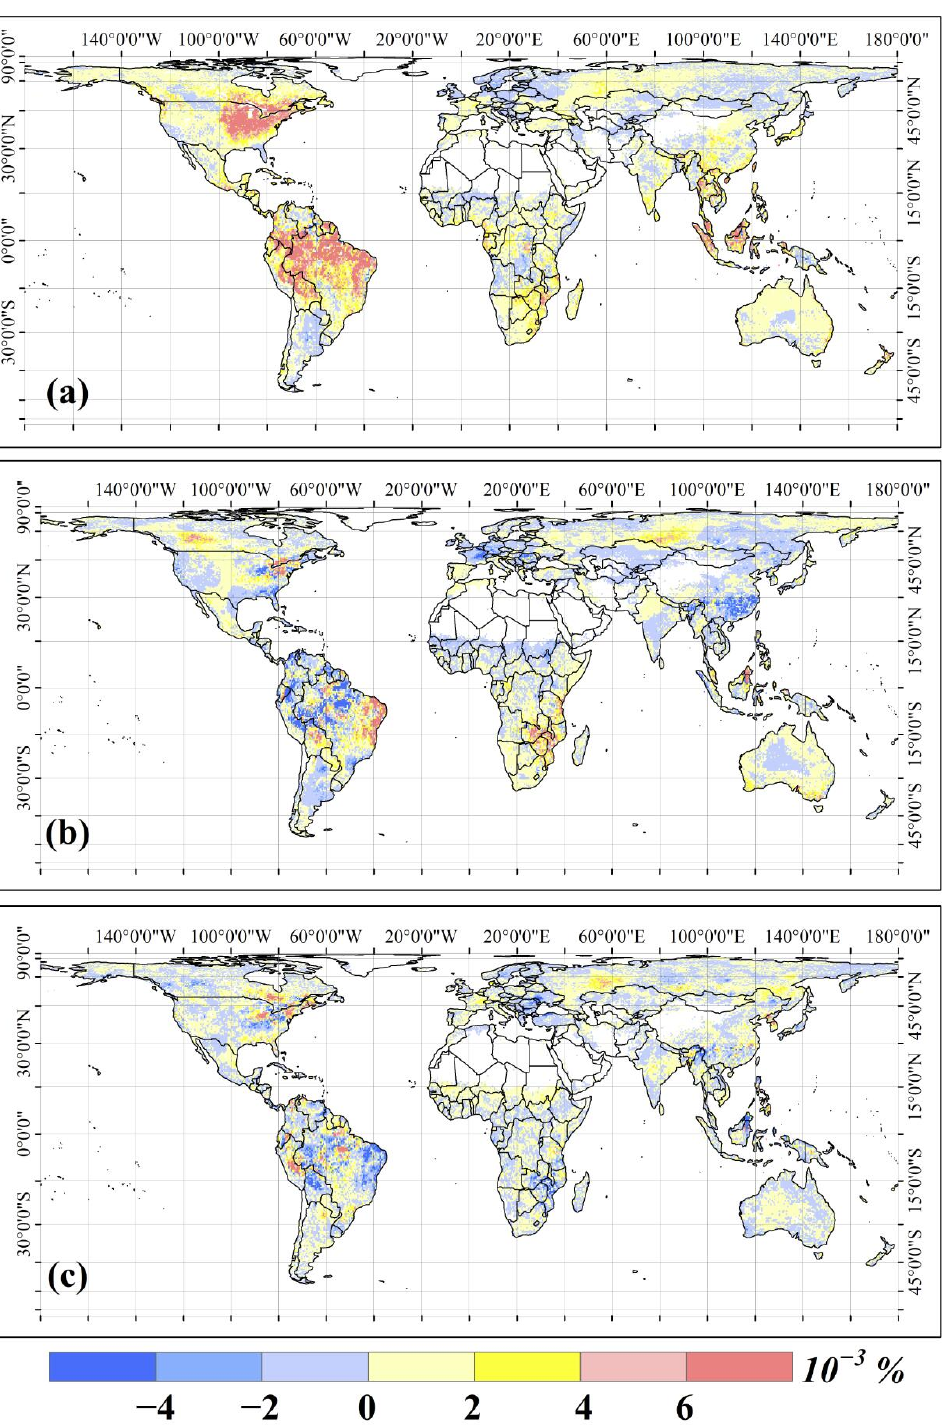
Figure 9. The contributions of ( a ) temperature, ( b ) precipitation, and ( c ) solar radiation to global IAV of NEP.